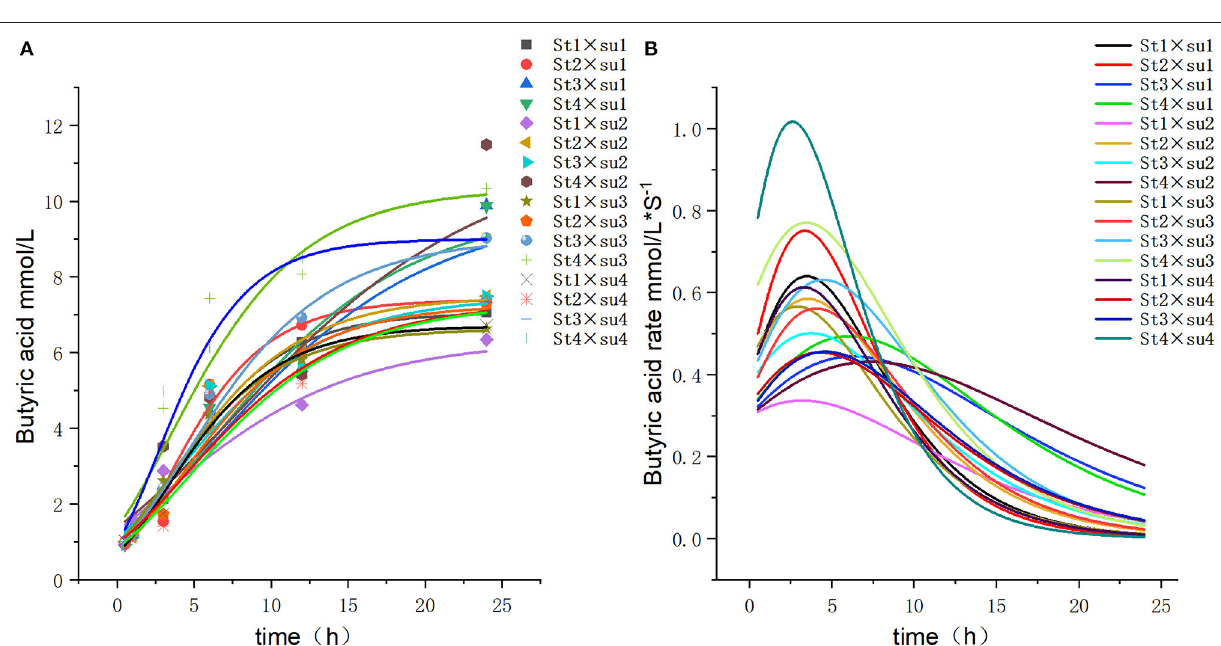
in H sugar groups, while the relative abundance of Ruminobacter was the lowest in these groups. The relative abundances of both p-75-a5 and Sphaerochaeta were affected by the interaction of starch and sugar. Furthermore, the relative abundance